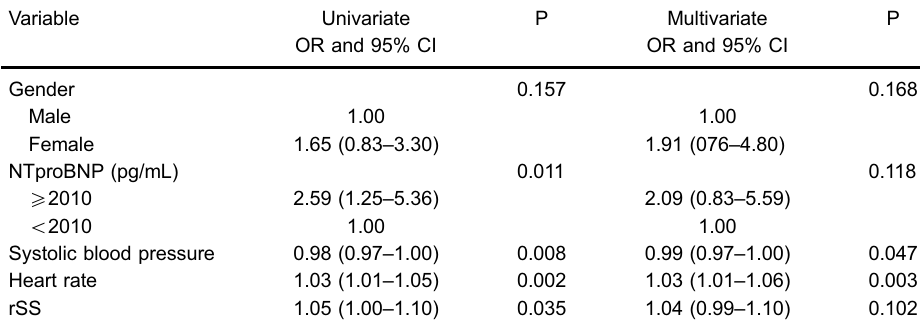
Table 4. Independent predictors of pulmonary congestion according to multivariate regression analysis.